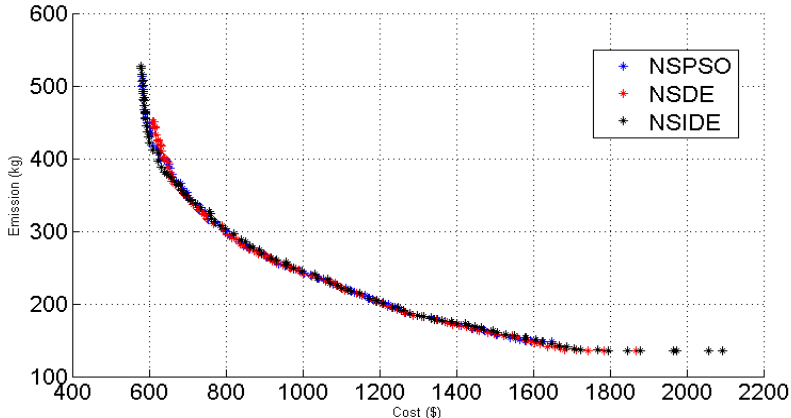
Figure 12. The results of implementing different methods without considering the limitations of upstream power exchange (cost and emission based).